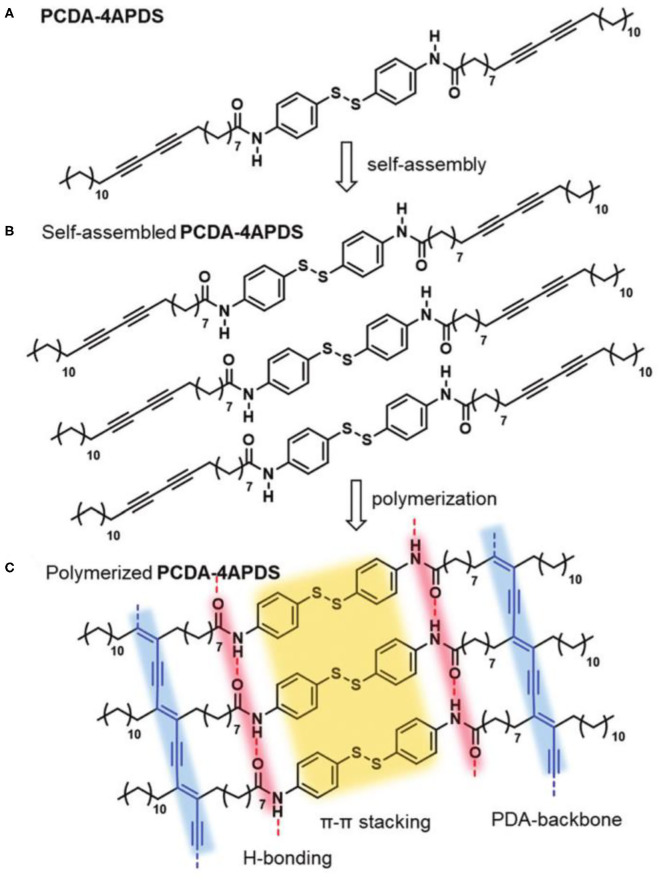
(A) Chemical structure of the diacetylene monomer, PCDA-4APDS. (B) Schematic illustration of molecular self-assembly of PCDA-4APDS. (C) Schematic representation of polymerized PCDA-4APDS showing intermolecular p–p stacking and H-bonding interactions, and the poly(ene–yne) backbone of the PDA. Reprinted with permission from Lee et al. (2019a). Copyright 2019, Royal Society of Chemistry.